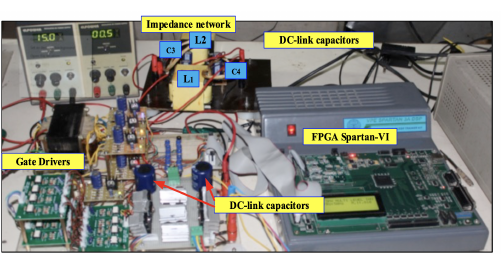
Fig. 6. Harmonic spectrum: (a) M a = 0.7 (b) M a = 0.907